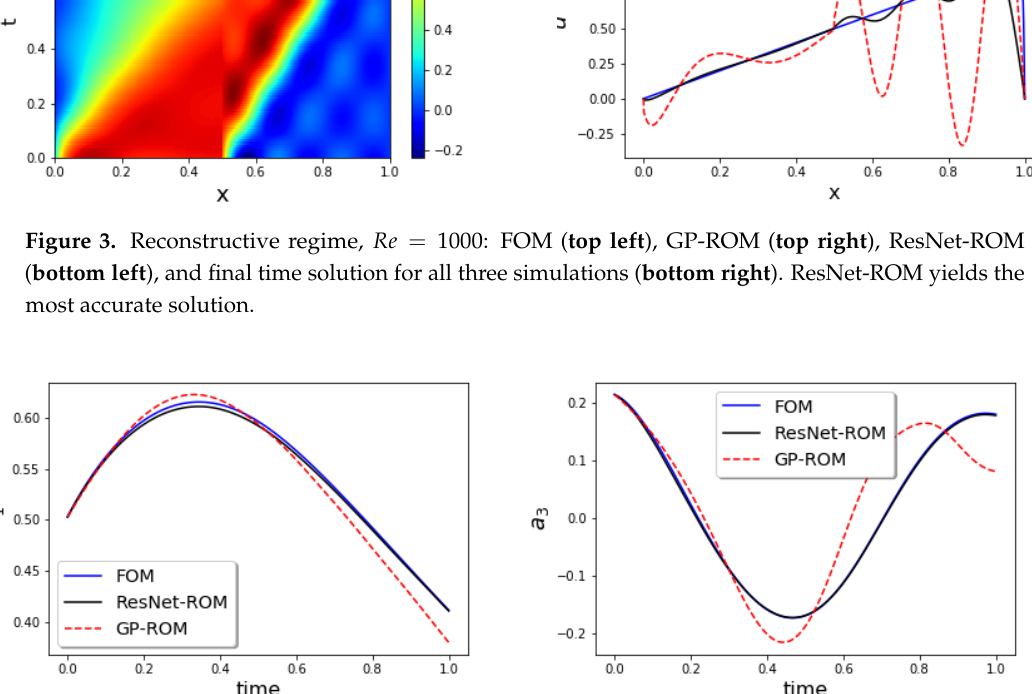
Figure 4. Reconstructive regime, Re = 1000: Time evolution of ROM coefficients a 1 and a 3 for FOM, GP-ROM, and ResNet-ROM. ResNet-ROM yields the most accurate